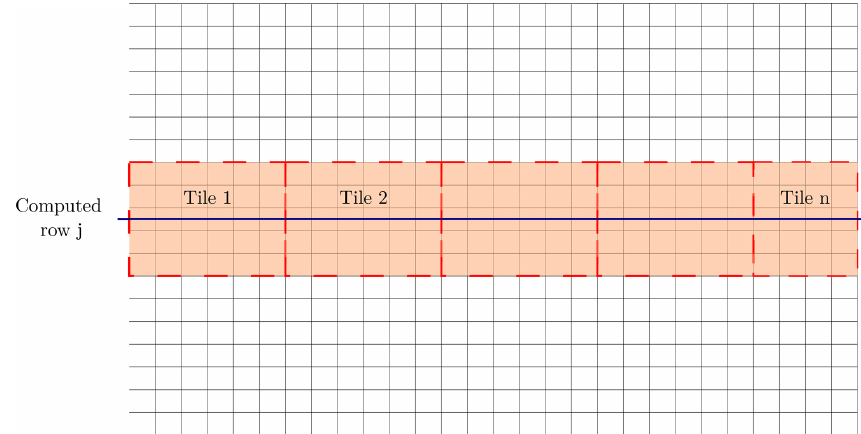
Figure 1. Schematic domain decomposition for solving the ADI equation system.